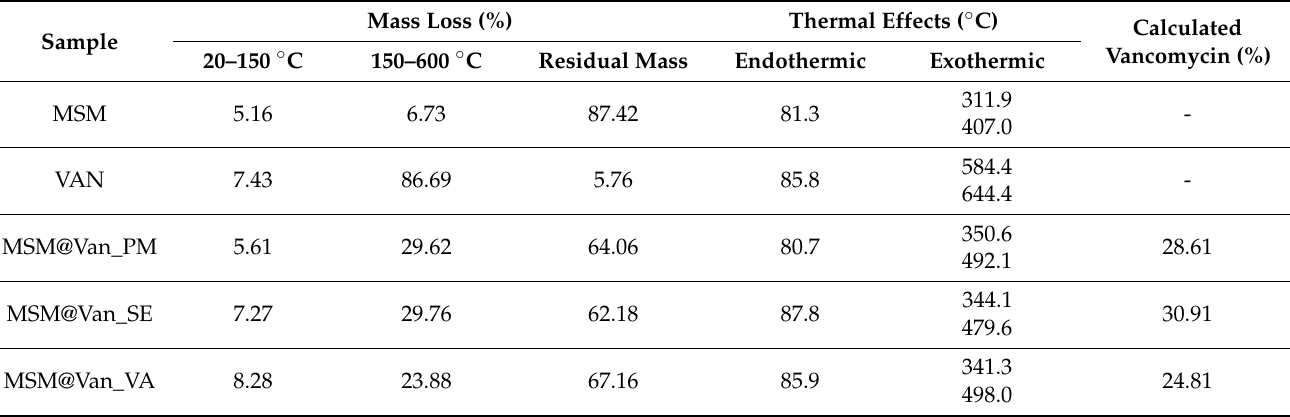
Table 4. Mass loss and loading efficiencies calculated according to TG-DSC